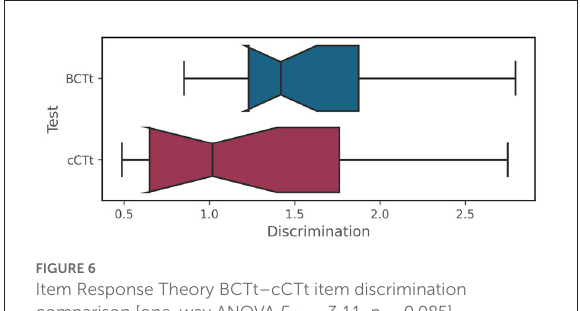
FIGURE6 Item Response Theory BCTt–cCTt item